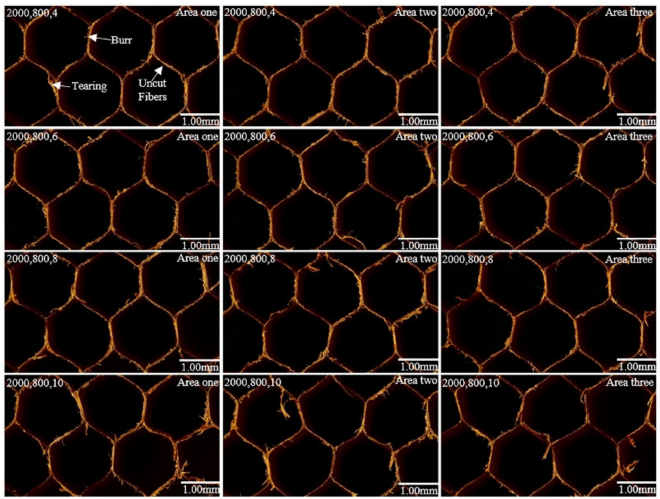
Figure 21. Surface morphology at different cutting